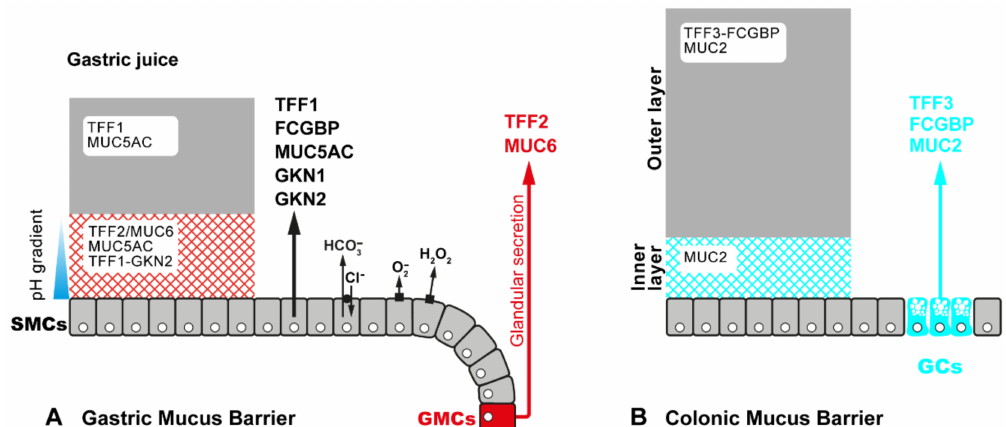
Figure 2. Schematic model of the gastric mucus-bicarbonate barrier ( A ) and the colonic mucus barrier ( B ), respectively. Both barriers consist of a loose outer layer (grey) and a firmly attached inner layer (hatched). ( A ) The gastric mucus originates from different cell types, i.e., surface mucous cells (SMCs) and glandular mucous cells (GMCs, i.e., fundic mucous neck cells and antral gland cells, respectively). SMCs secrete TFF1, gastrokines GKN1 and GKN2, FCGBP and the mucin MUC5AC, whereas GMCs secrete TFF2 and the mucin MUC6. SMCs also secrete bicarbonate (HCO 3 − ) in exchange with Cl − , creating a pH gradient along the inner layer. Furthermore, as part of the innate immune defense, they generate H 2 O 2 and O 2 − via dual oxidase (DUOX) and NADPH oxidase (NOX), respectively. Monomeric TFF1, which is the predominant soluble form of TFF1, appears also in the gastric juice. The TFF2/MUC6 complex seems to be concentrated in the inner mucus layer. ( B ) TFF3, together with FCGBP and the mucin MUC2, is secreted from goblet cells (GCs). The heterodimer TFF3-FCGBP is easily soluble and seems to be concentrated in the outer